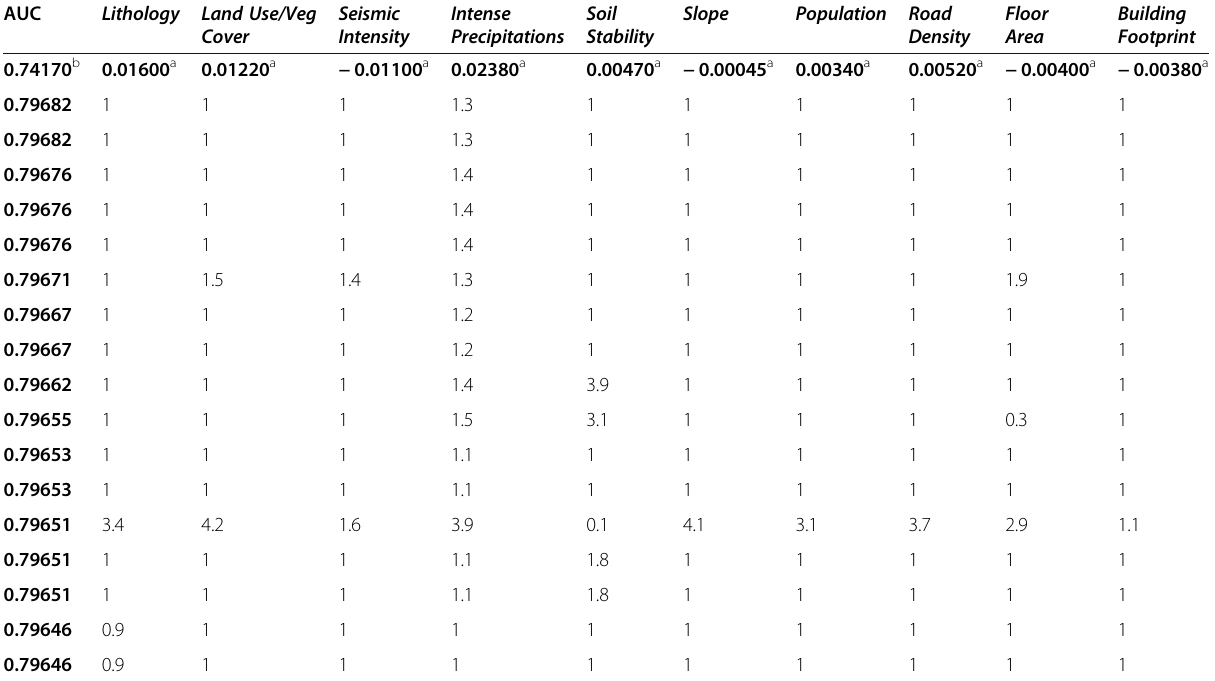
Table 8 Randomly selected combination of multipliers of coefficients of the LOGIT model (percentile-discretized) to calibrate it for optimal results in defining the landslide susceptibility map AUC Lithology Land Use/Veg